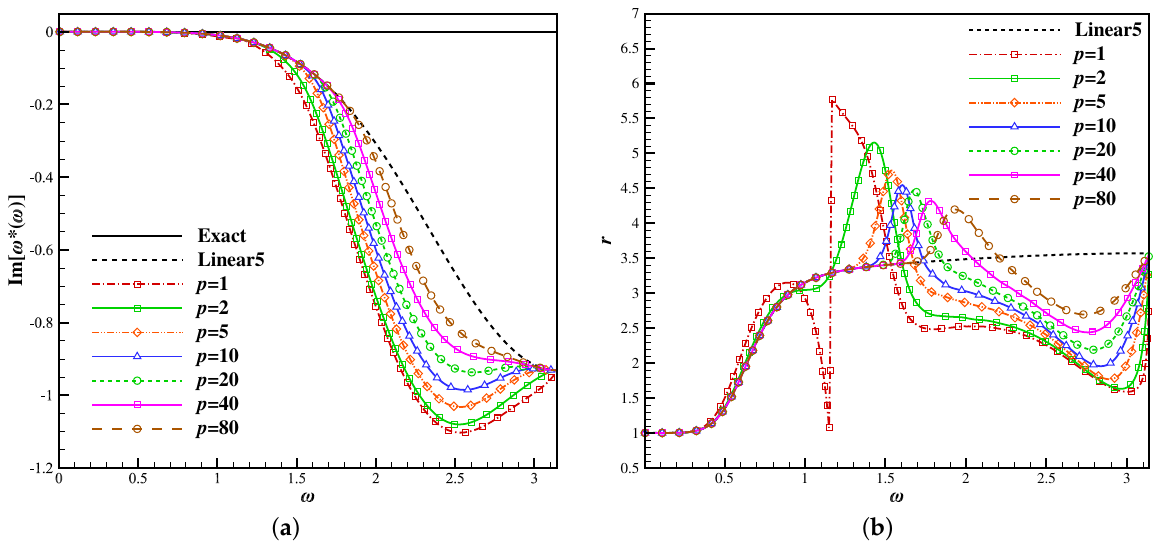
Figure 4. Spectral properties of the WCNS5-AT scheme with the different parameter p : ( a ) dissipation; ( b ) dispersion-dissipation